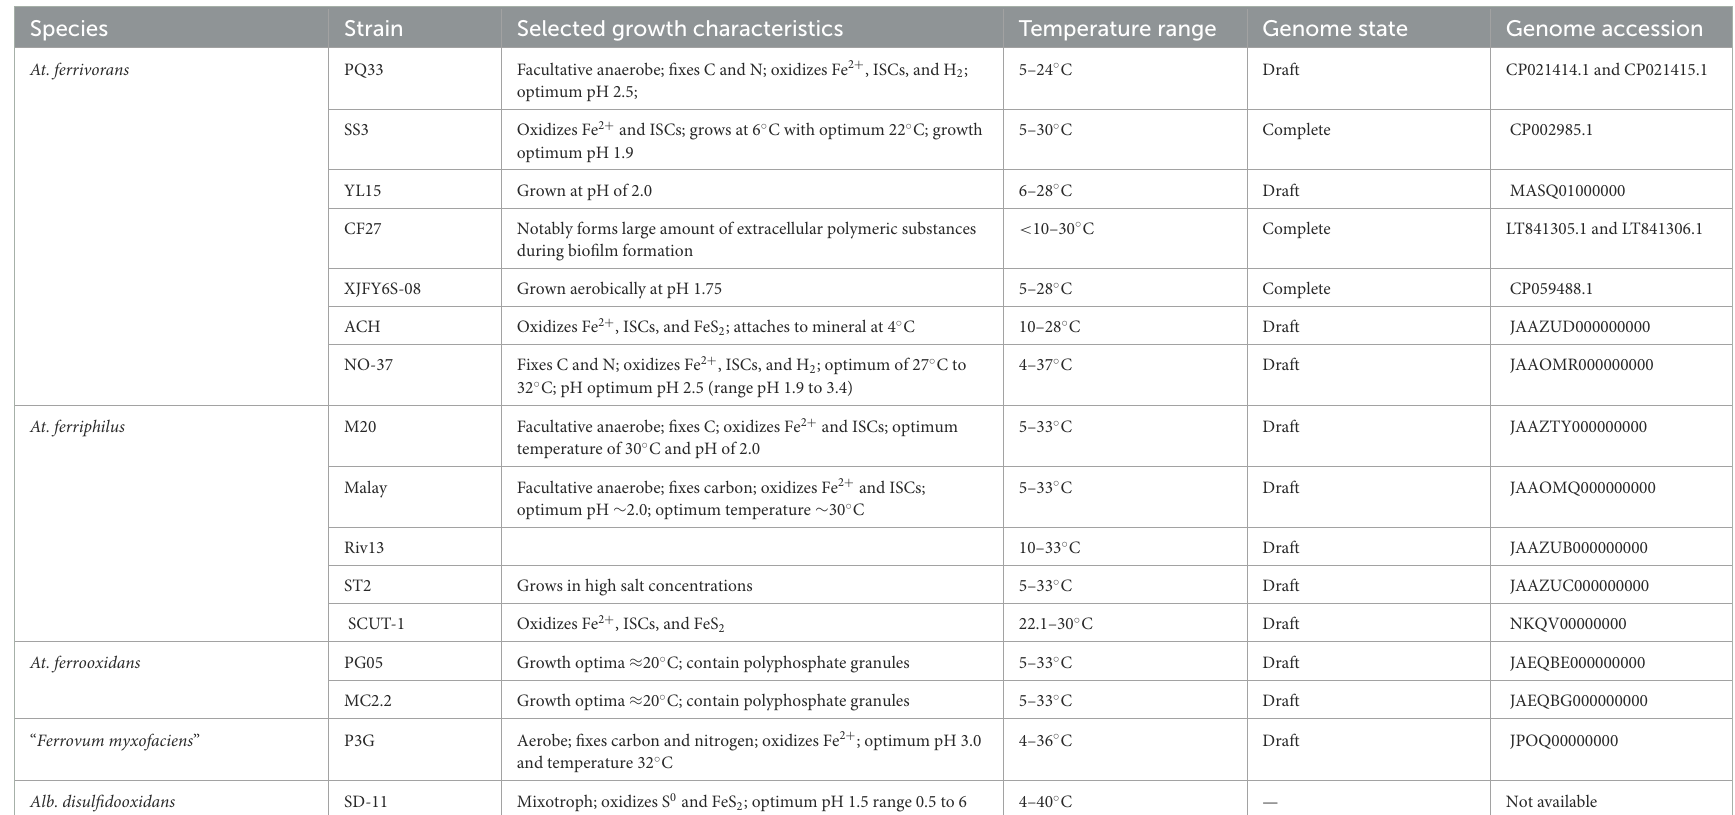
TABLE 1 Selected characteristics of eurypsychrophilic acidophile species along with their genome availability.